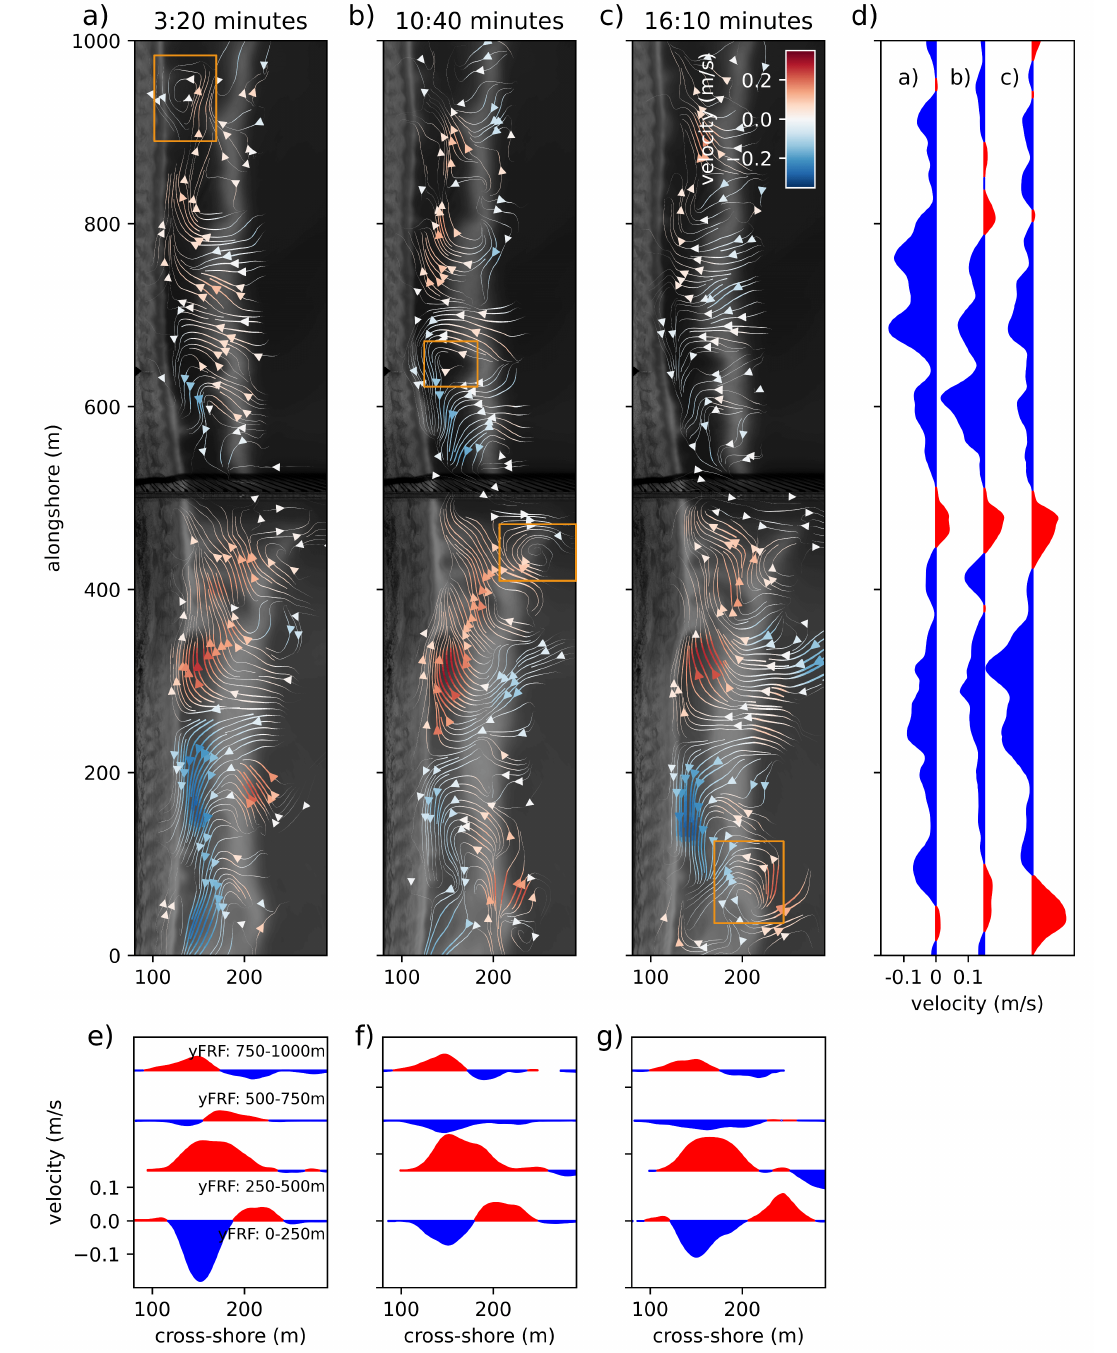
Figure 10. Two minute averages centered on three different times in the same video on 11 September 2019 are presented in ( a – c ) to highlight various processes that wave-averaged movie could aide in understanding and quantifying processes. The alongshore variation of average cross-shore velocity at points offshore of xFRF = 200 m from each snapshot in ( a – c ) are provided in ( d ). Cross-shore variation in longshore current are provided immediately beneath each map in ( e – g ). The four separate 250 m stretches of beach were averaged to highlight how the cross-shore profile of longshore current varies in both the alongshore direction and time. Orange boxes in ( a – c ) highlight transient eddies in the